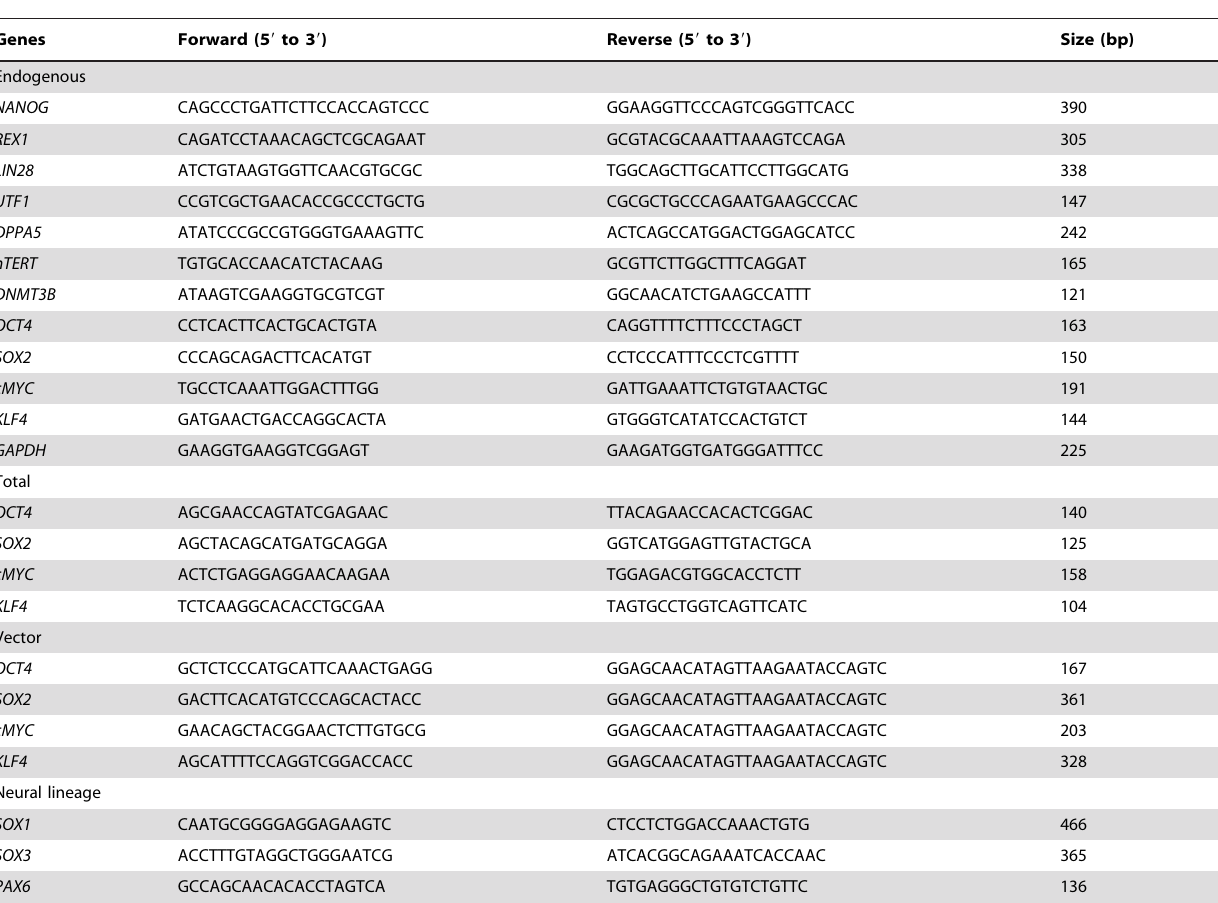
Table1. Primers for